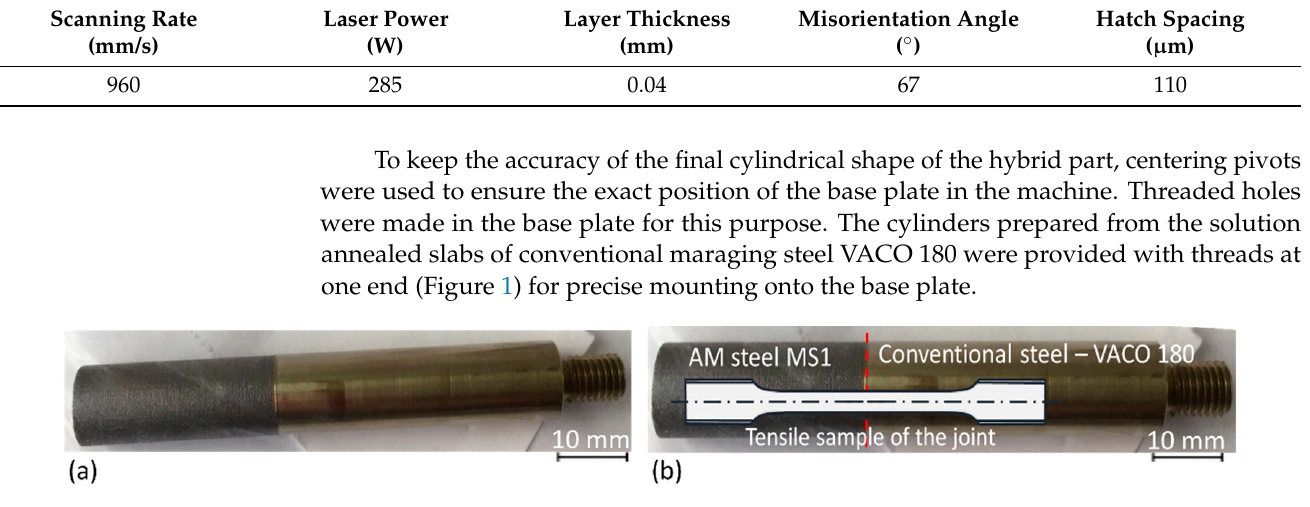
Figure 1. ( a ) Hybrid part (MS1 left, VACO 180 right), ( b ) position of the tensile test sample for determining the mechanical properties of the hybrid part.